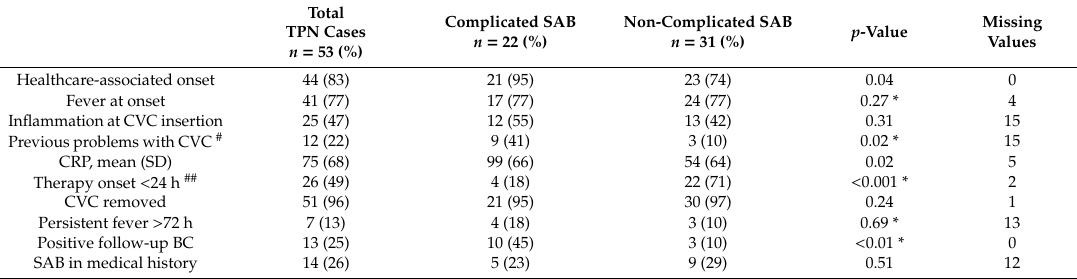
Table 5. Comparison of TPN patients with and without complicated S. aureus